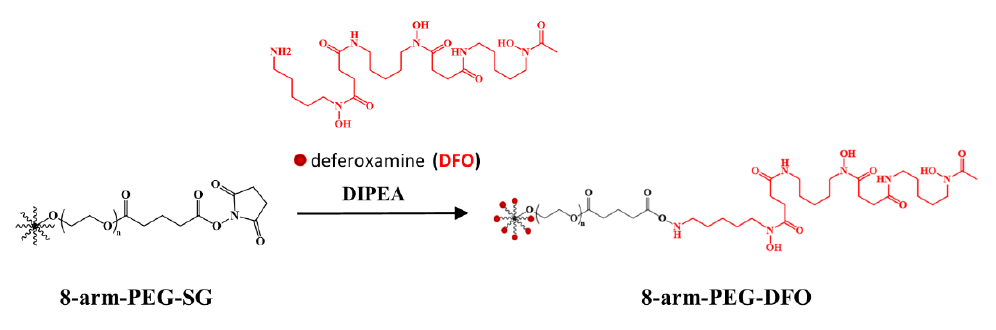
Figure 1. Synthetic route of the 8-arm-polyethylene glycol- deferoxamine (8-arm-PEG-DFO)